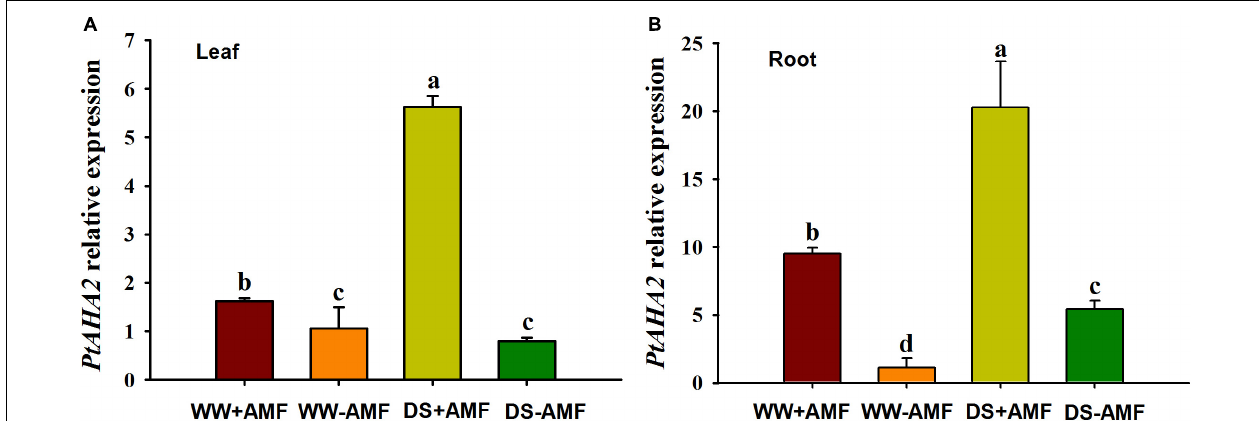
FIGURE 4 | Effects of Funneliformis mosseae on relative expression of leaf (A) and root (B) plasma membrane H + -ATPase gene PtAHA2 in trifoliate orange ( Poncirus trifoliata ) seedlings subjected to well-watered (WW) and drought stress (DS). Data (means ± SD, n = 3) followed by different letters above the bars indicate significant differences ( P < 0.05) between treatments.